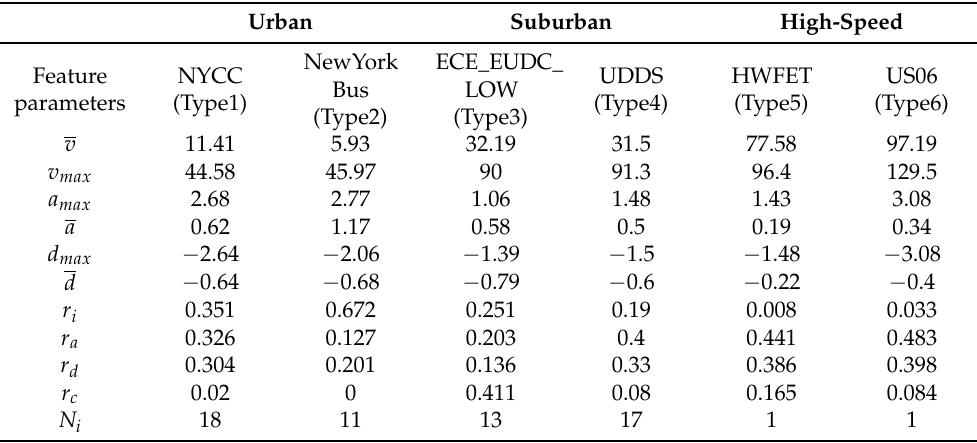
Table 2. The main characteristic parameters of three typical driving